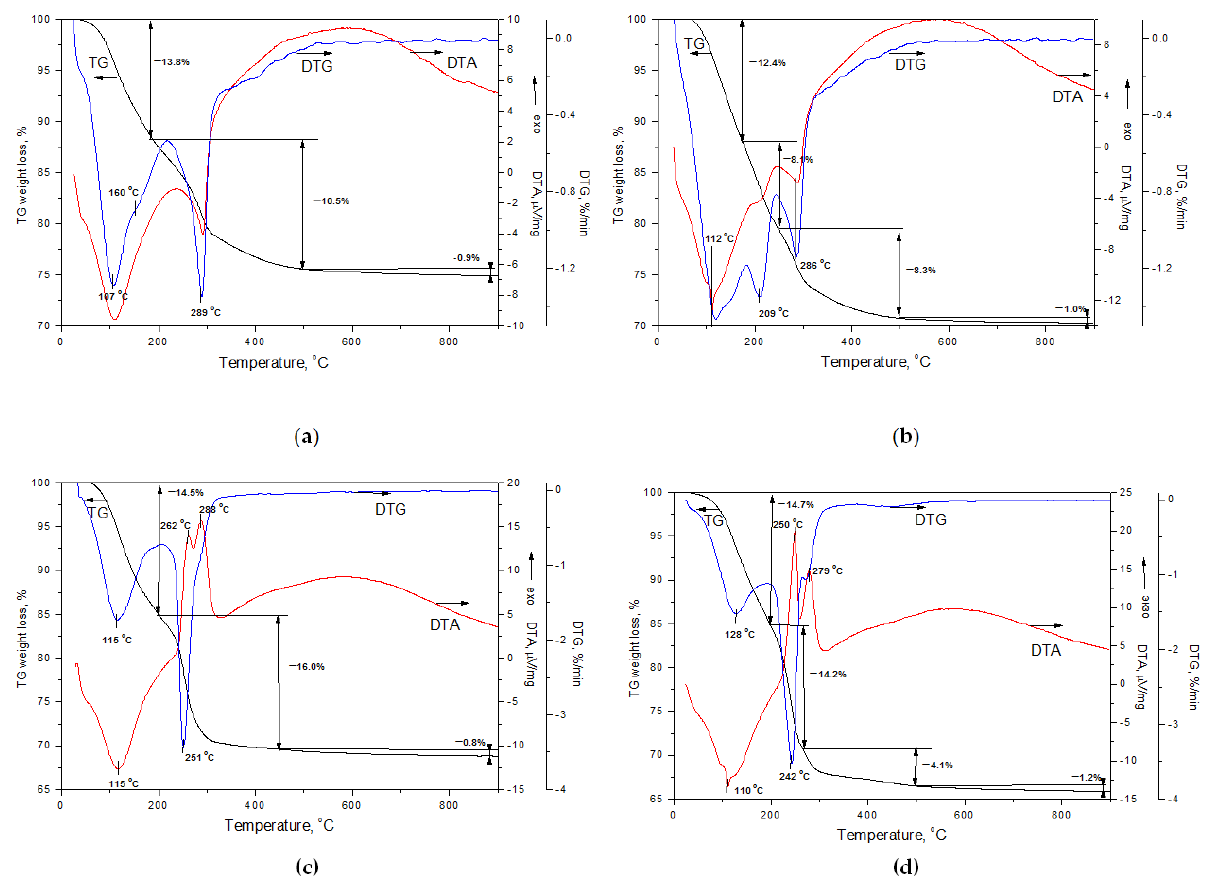
Figure 1. TG, DTG, and DTA curves for dried 10Ni/Al 2 O 3 -CI ( a ), 20Ce 0.2 Ni 0.8 O 1.2 /Al 2 O 3 -CI ( b ), 10Ni/Al 2 O 3 -SG ( c ), and 20Ce 0.2 Ni 0.8 O 1.2 /Al 2 O 3 -SG ( d ) catalysts.